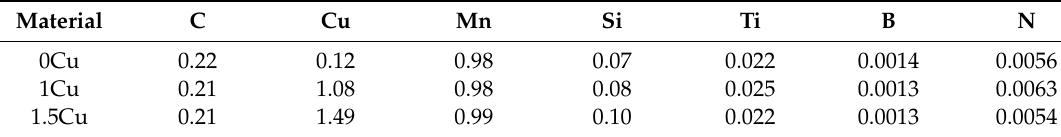
Table 1. Chemical compositions of experimental steels in wt.%.